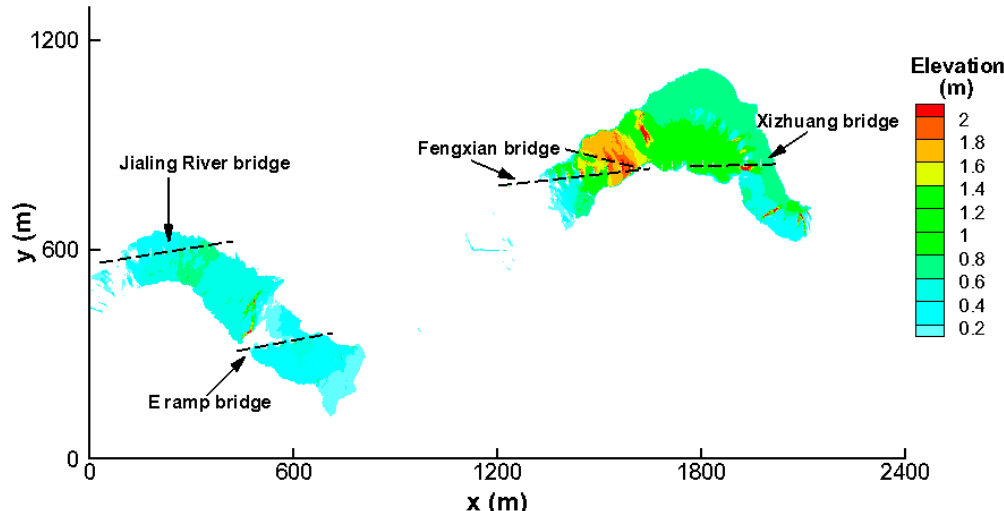
Figure 8. Di ff erences in water levels with and without bridge piers for 100-year flood Figure 8. Differences in water levels with and without bridge piers for 100-year flood conditions.